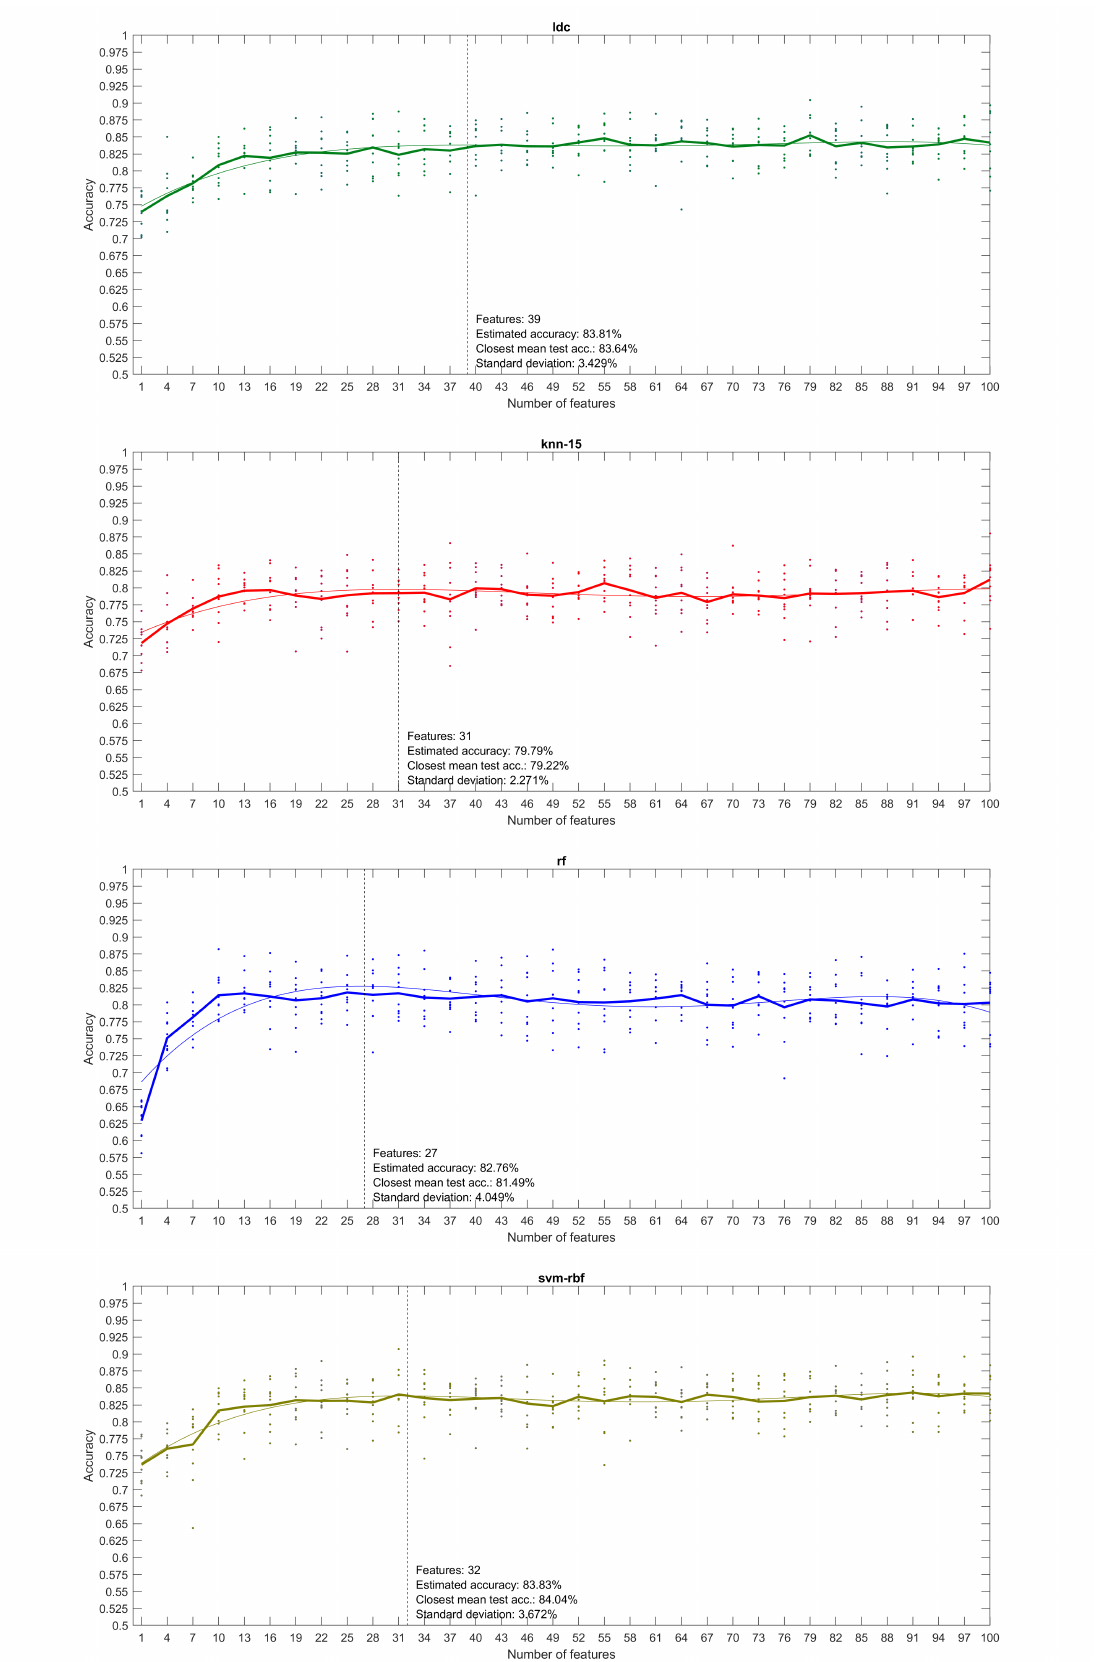
Figure 11. CME cross validation training results per feature subset and fitted curve used to select the best